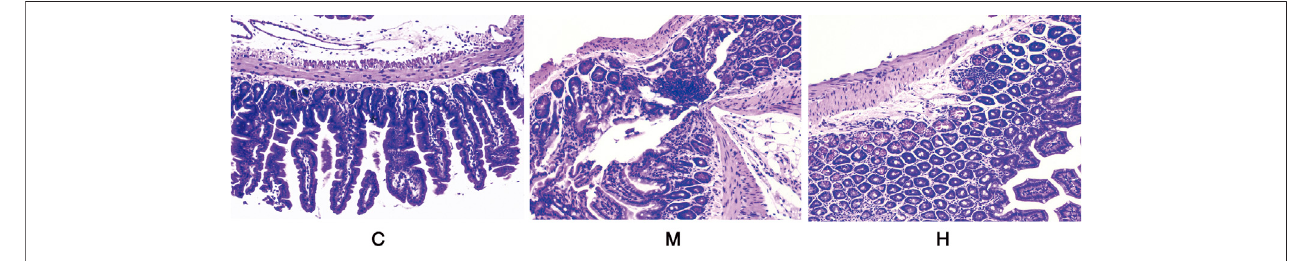
FIGURE 3 | Histological observations of the colon tissues in different groups (HE staining) (10 × 40). C: normal control; M: model control; H: HQT